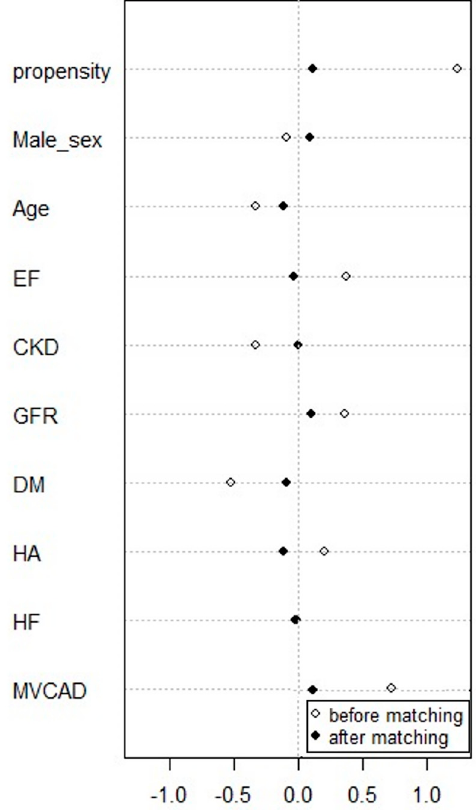
Figure 1. Propensity score matching of study and control groups. EF—left ventricular ejection fraction; CKD—chronic kidney disease; GFR—estimated glomerular filtration rate; DM—diabetes mellitus; Table 2. Demographic and clinical characteristics of non-CI-AKI and CI-AKI